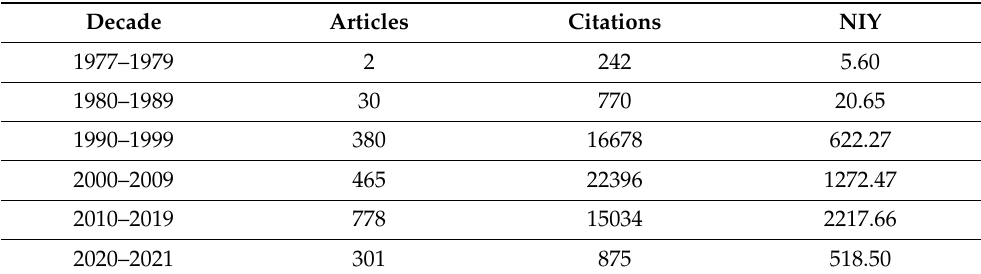
Figure 2. Impact scholarly publication trend on fuzzy sets. Table 2. Intertemporal analysis. Articles, citations and Normalized Impact per Years (NIY).